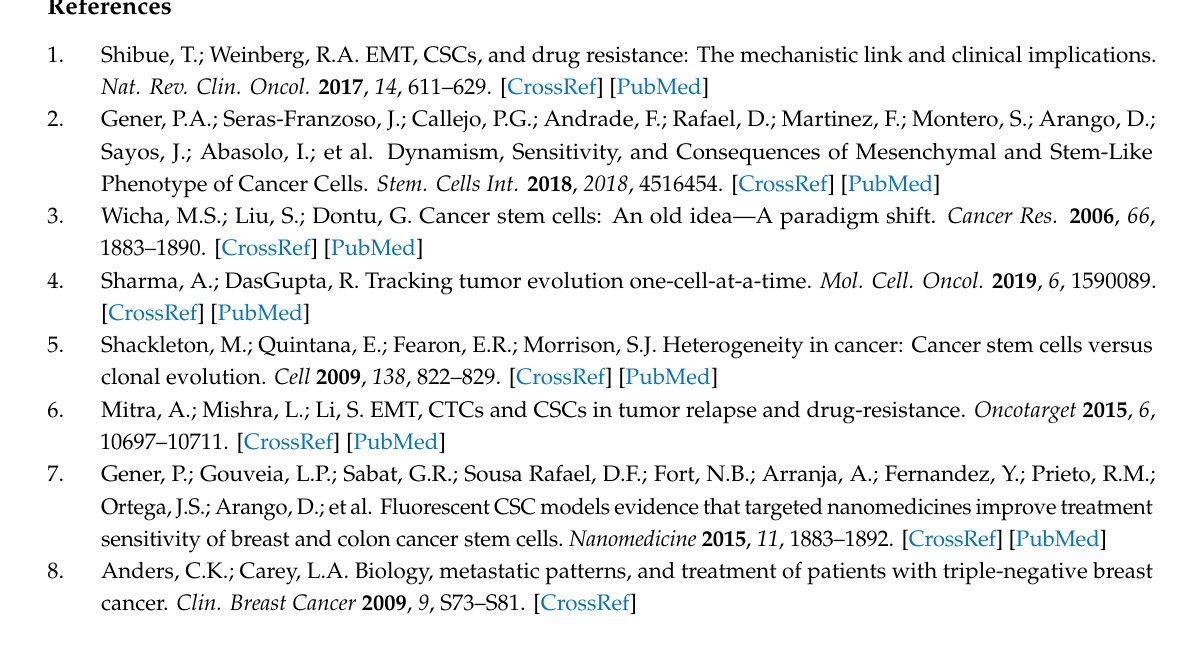
Figure S1: CD44 and CD24 expression in MDA-MB-2317-ALDHA1 / tdTomato cells; Figure S2: MDA-MB-231 mammosphere culture; Figure S3: HCT8 reversion process; Figure S4: AKT2 mRNA expression in the tumor derived from MDA-MB-231 CSC-like and non-CSC cells; Figure S5: AKT1, AKT2, AKT3 mRNA expression in MDA-MB-231 CSC, Figure S6: AKT2 downregulation and gene expression profile of various mesenchymal and epithelial breast and colon cancer cells; Figure S7: E ff ect of AKT2 silencing on invasion, transformation, proliferation and migration; Figure S8: E ff ect of AKT2 silencing in parental MCF7 epithelial cells; Figure S9: Gene expression after AKT2 silencing in MDA-MB-231 cell line, Table S1: List of the cell lines used in this study and their phenotype; Table S2: List of the primers used in the study and their sequences; Table S3: List of primary antibodies used in the study and their specifications; Text S1: Supplemental Experimental Procedures—Cell Culture; Text S2: Supplemental Experimental Procedures—Microarray